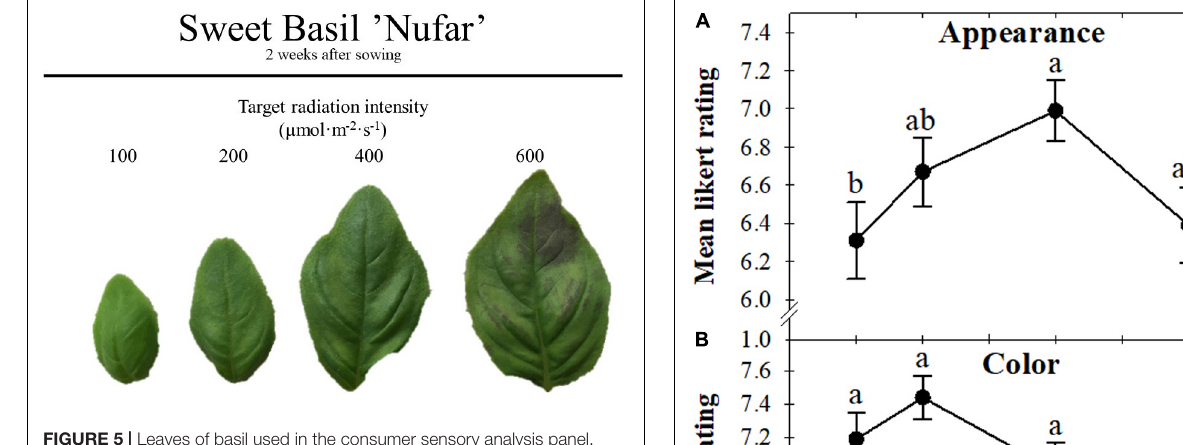
FIGURE 5 | Leaves of basil used in the consumer sensory analysis panel. Sweet basil “Nufar” ( Ocimum basilicum ) was grown under radiation intensities of 100, 200, 400, or 600 µ mol · m − 2 · s − 1 for a 16 h photoperiod to create daily light integrals of 6, 12, 23, or 35 mol · m − 2 · d − 1 for 2 weeks after sowing.